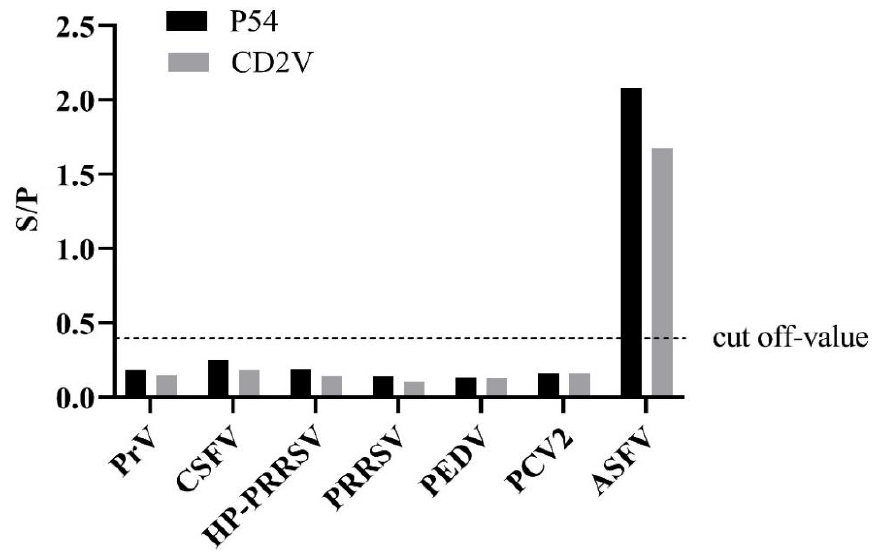
Figure 2. Specificity test of the dual indirect ELISA method. Only ASFV-positive serums show an OD value greater than the cut-off value.